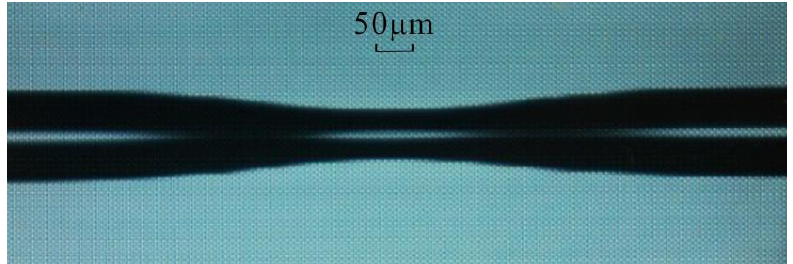
Figure 1. Image profile of an abrupt taper [11].